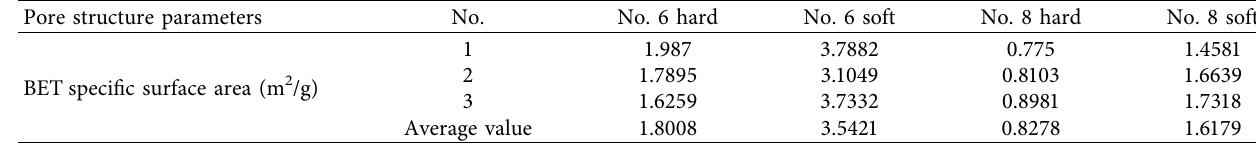
Table 1: BET specific surface areas of the different coal seams. Pore structure parameters